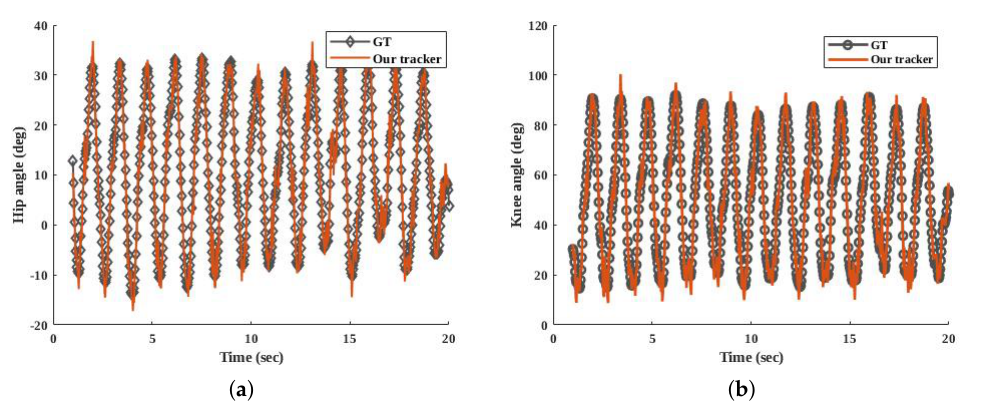
Figure 6. Measured and estimated results of our tracker for the right leg of one participant in HuGaDB dataset who was a 24-year old male with 177 cm stature and 75 kg body mass. ( a ) shows the angle between thigh and hip ( θ H ). ( b ) shows ( θ K ) measured using the accelerometers and estimated using 1 1 our